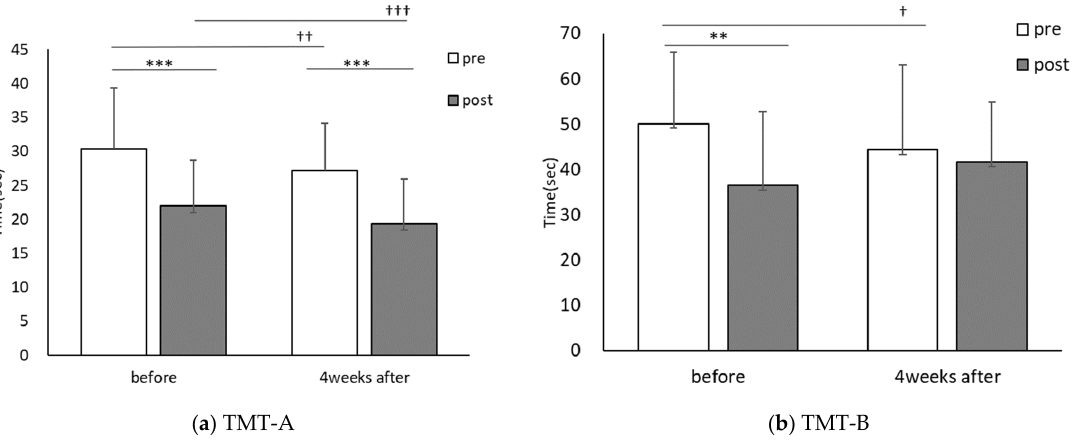
Figure 6. Comparisons of each trial before and the 4-week PX supplementation period: TMT; pre: